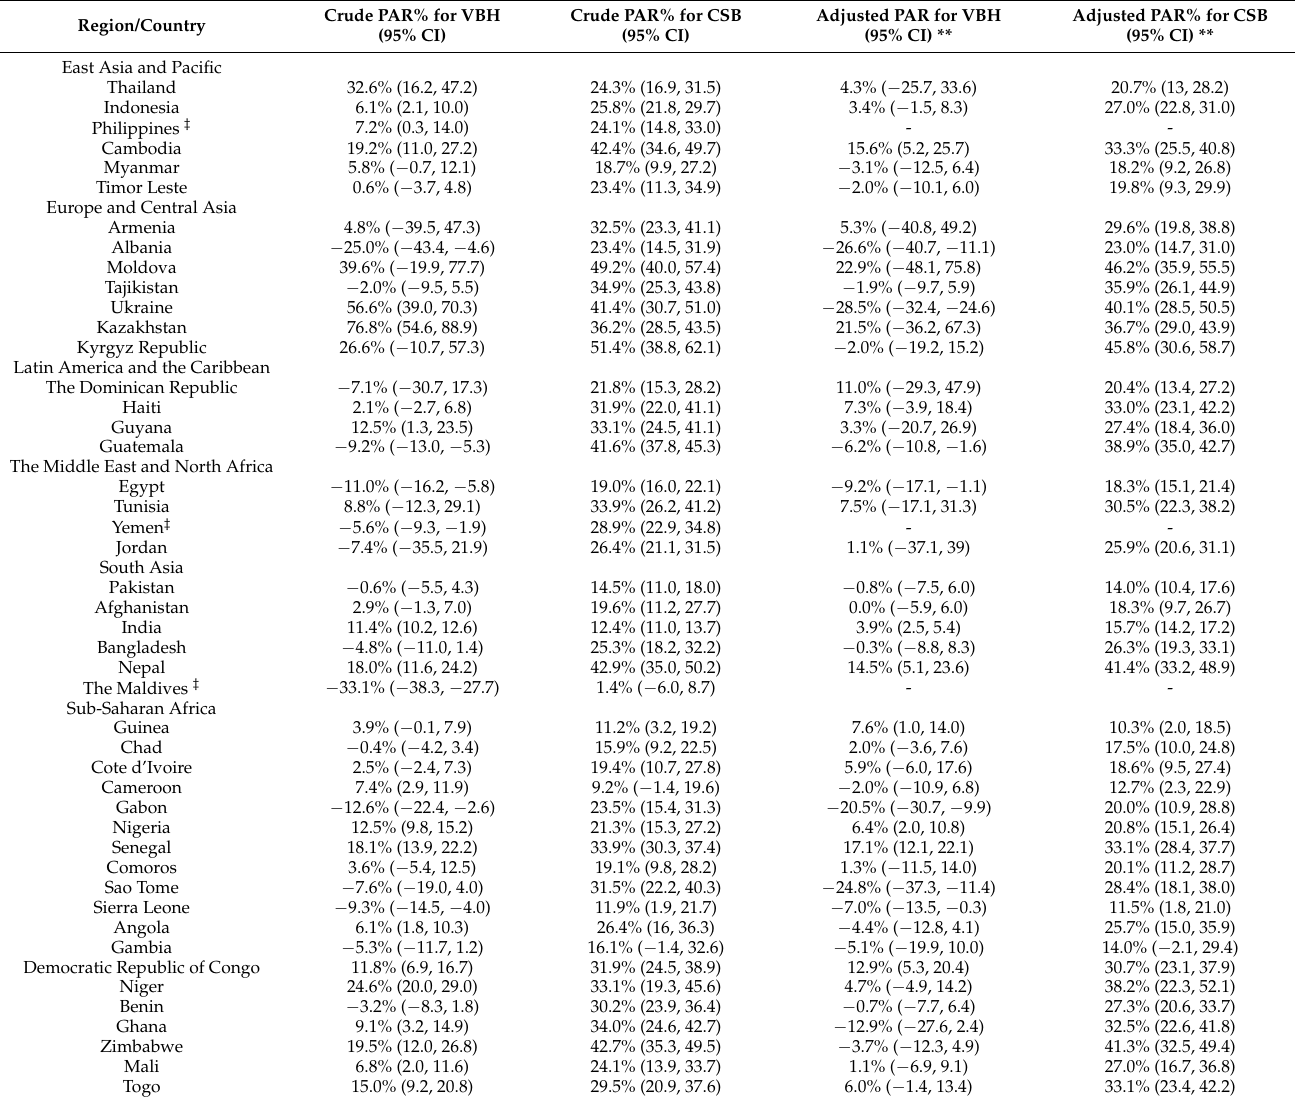
Table 3. Population Attributable Risk percent for vaginal births at home (VBH) and caesarean section births (CSB) relative to vaginal births at a health facility